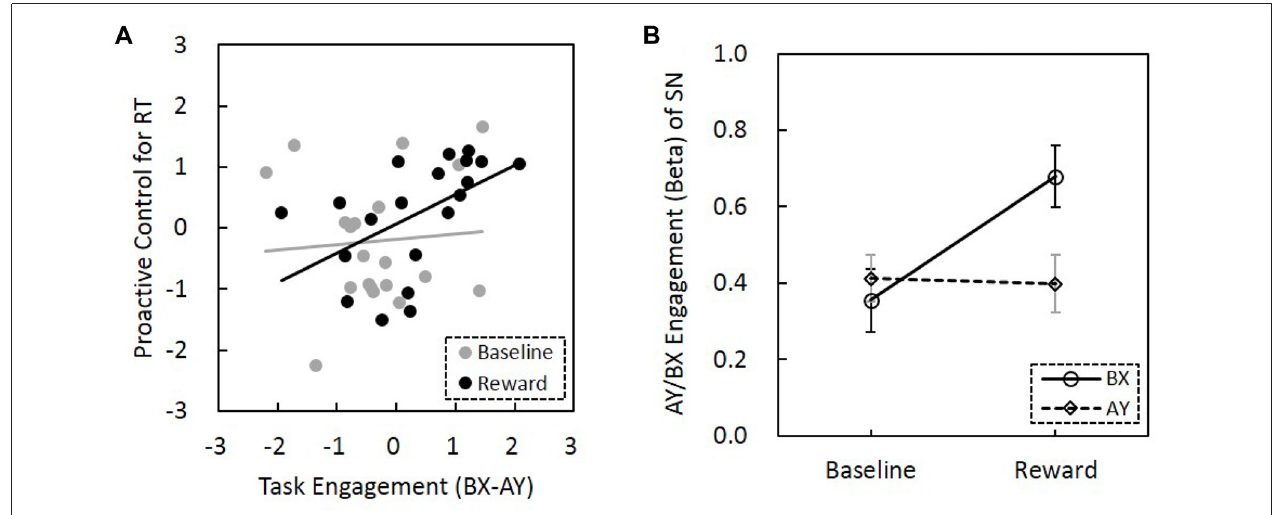
FIGURE 6 | Relationship among reward motivation, task engagement of SN and proactive control. (A) Compared to the baseline, reward motivation increased the association between task engagement (activity) of SN (BX-AY) and proactive control. Before the comparison, Fisher’s r-to-z transformation was performed to increase the normality of the correlation coefficients, and z values of correlation coefficients were subjected to paired sample t -test (baseline vs. reward). The horizontal and vertical values represent standardized z -scores. (B) The interaction between reward and trial types was significant, suggesting reward differentially influenced the SN engagement for AY and BX trials (error bars denote standard errors). SN, salience